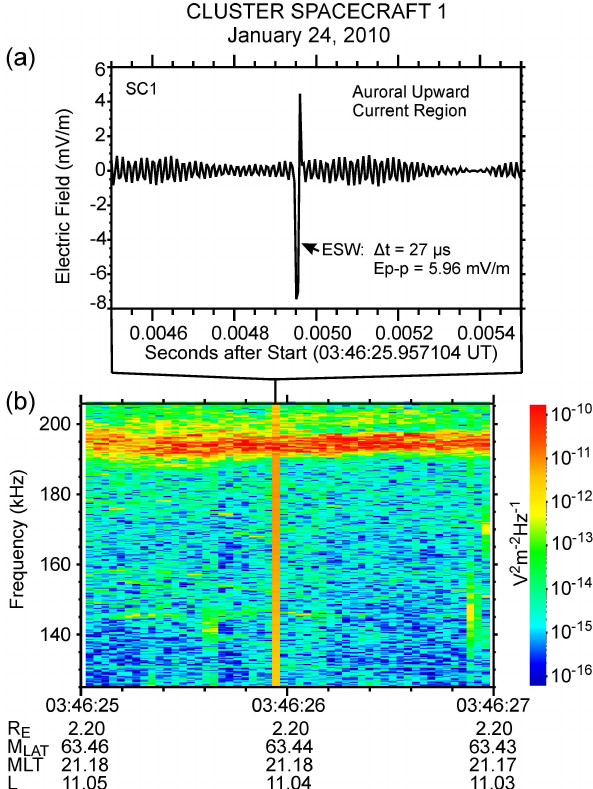
Fig. 2. WBD data obtained from Cluster 1 on 24 January 2010 in the auroral upward current region. (a) 1ms duration waveform showing sinusoidal waves and a bipolar pulse. (b) 2s frequency–time spec- trogram showing that the sinusoidal waves represent AKR around 192kHz and the pulse represents the broad band observed just be- fore